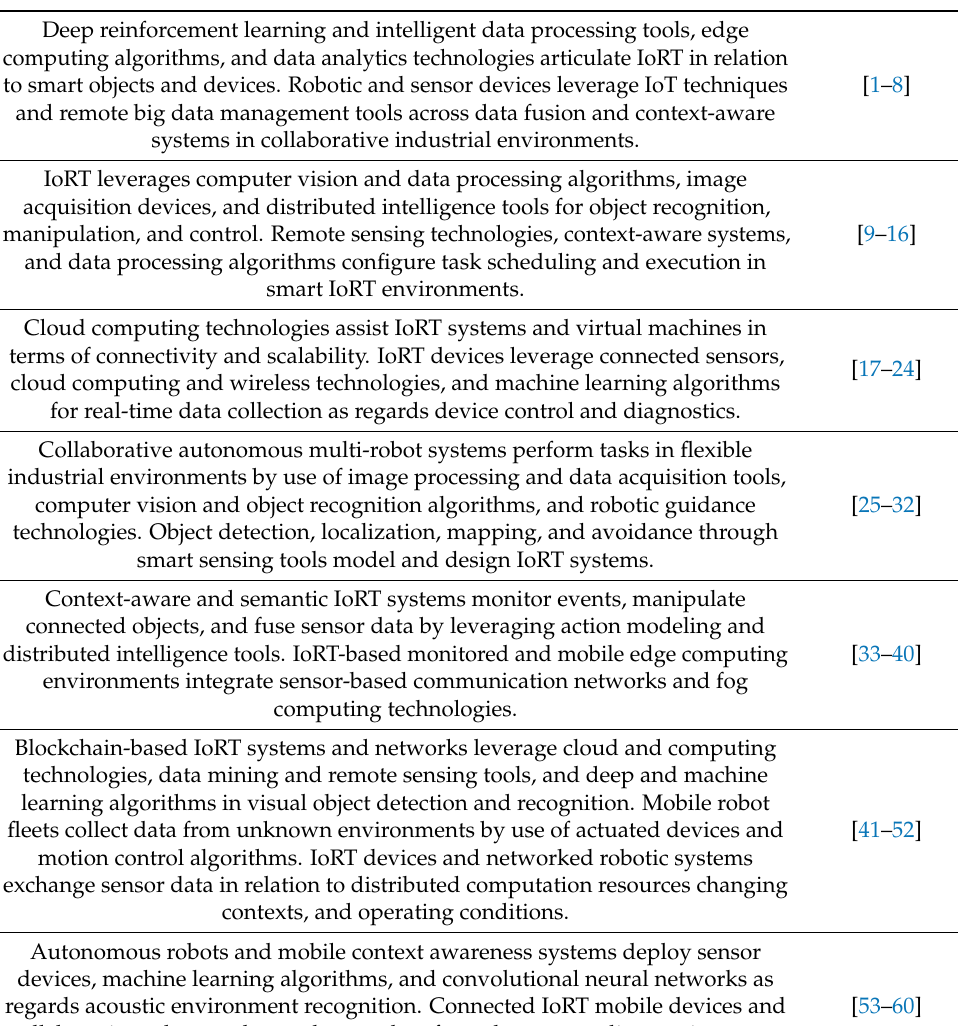
Table 2. Synopsis of cumulative evidence concerning analyzed topics and descriptive outcomes (research